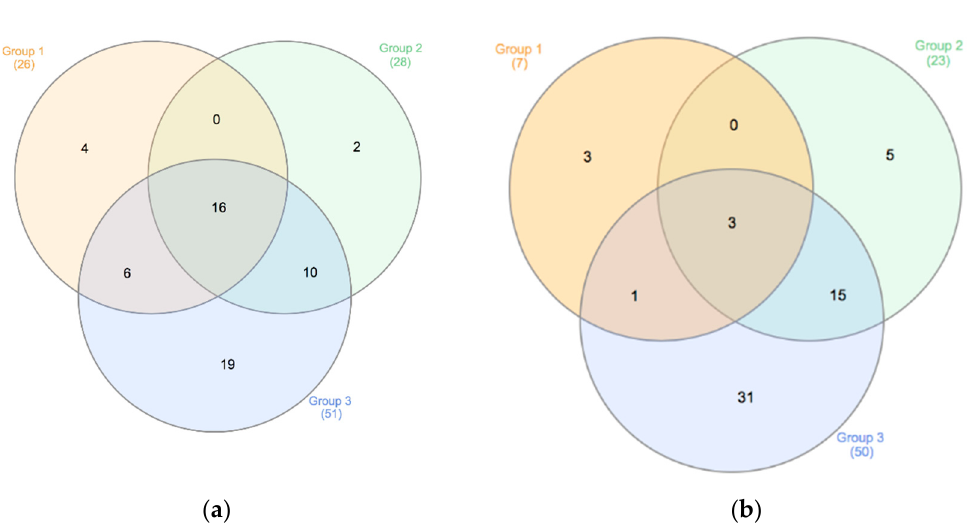
Figure 9. ‘Listening Post’ statistical data for Questions 4 in (a) and 5 in (b).